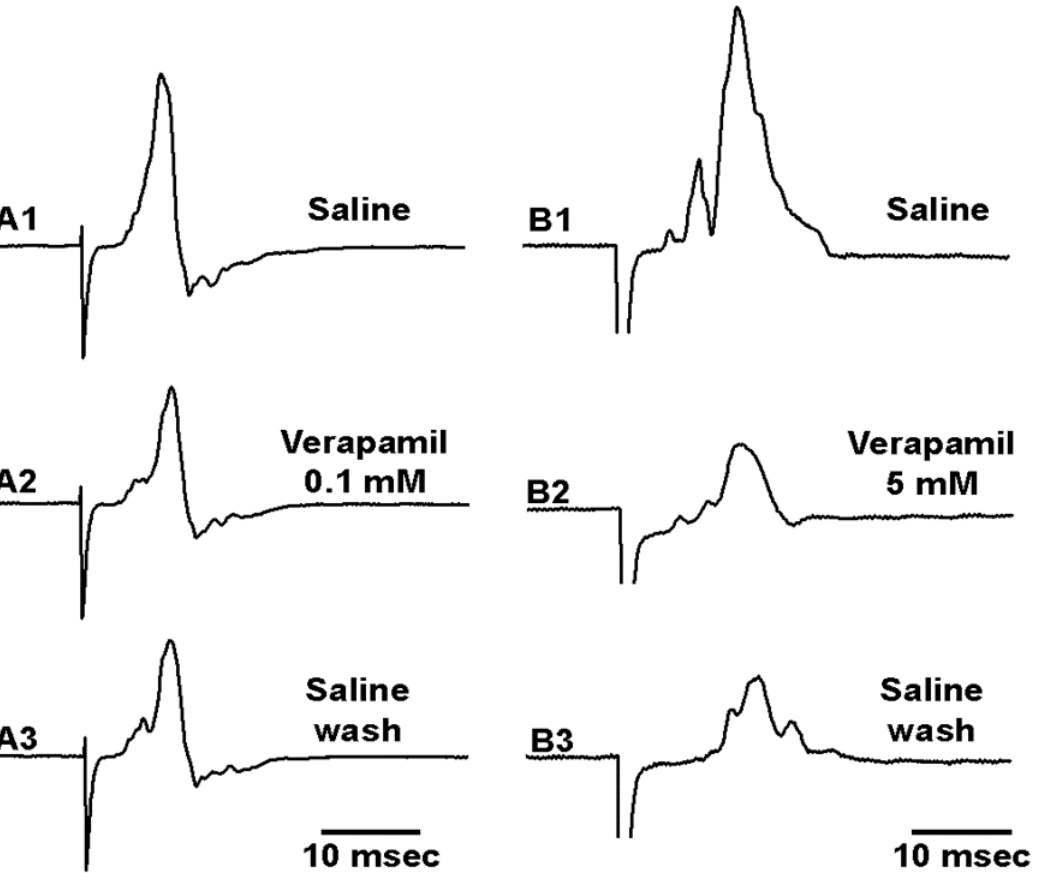
Figure 10. Representative effects of verapamil on the compound action potentials (CAPs) of the walking leg nerve. The CAPs in saline ( A1 , B1 ) and after 20 min of exposure to 0.1 mM ( A2 ) or 5 mM ( B2 ) of verapamil showed some depression for both concentrations. ( A3 , B3 ) Removal of verapamil with fresh saline did not fully recover the amplitude of the CAPs.